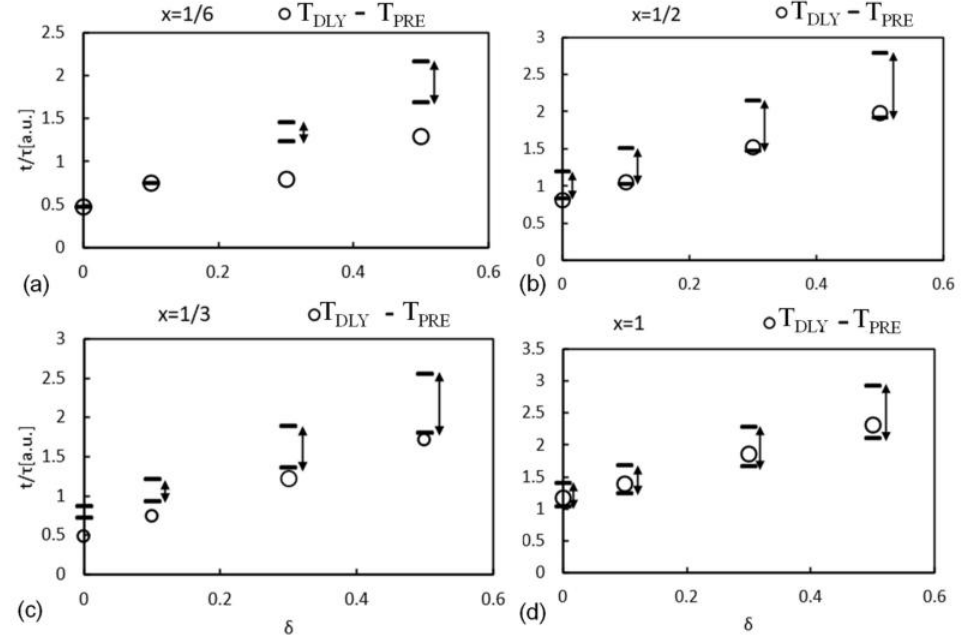
Figure 15. Optimum T PRE and T DLY vs. δ for x = 1/6 ( a ), 1/3 ( b ), 1/2 ( c ), and 1 ( d